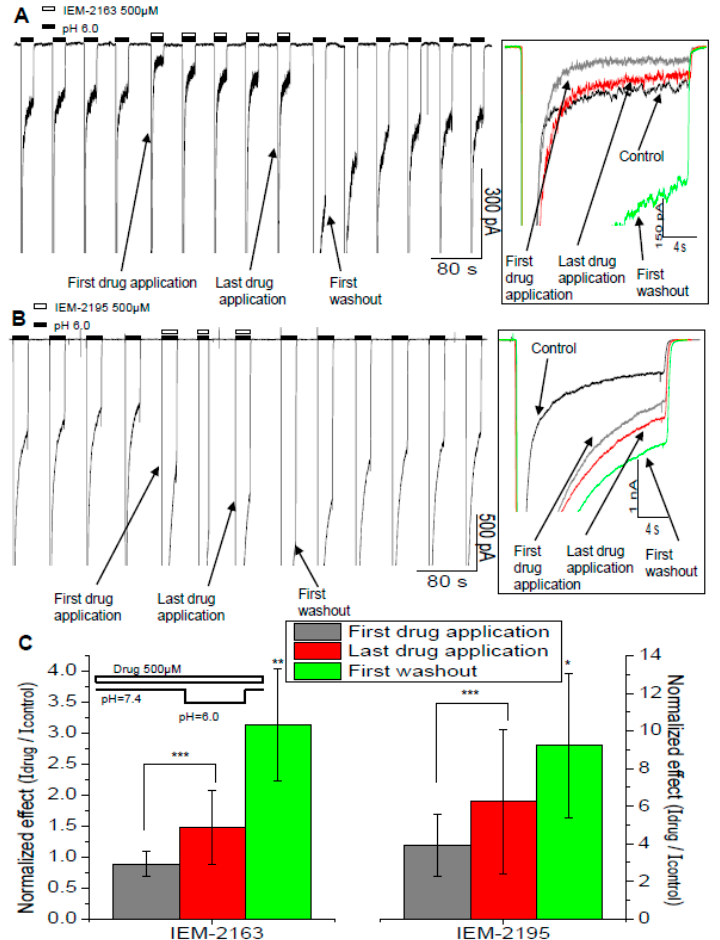
Figure 5. Non-monotonic effect development and washout of IEM-2163 and IEM-2195. ( A , B ) Representative recordings of the time course of experiments with IEM-2163 ( A ) and IEM-2195 ( B ). To the right are overlaid responses from the main panel. ( C ) The effect was the most pronounced in the protocol of continuous application. Number of * denotes statistical significance at * p < 0.05, ** p < 0.01, or *** p < 0.001, respectively, n ≥ 5. The average values were calculated as the ratio of amplitudes for the first drug application, last drug application, and first washout to the last control response,